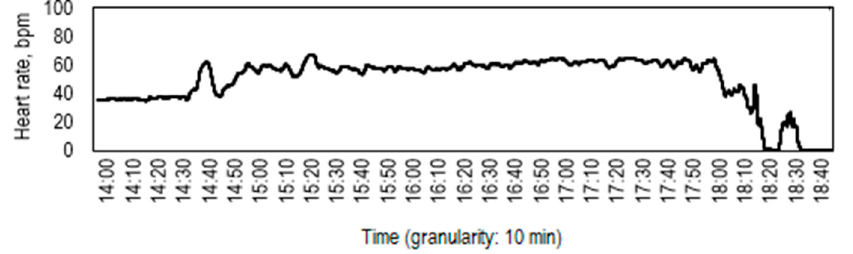
Figure 1. Heart rate of crayfish P. leniusculus four and half hours before molting. The fluctuating line shows heart rate, beats per minute (bpm).